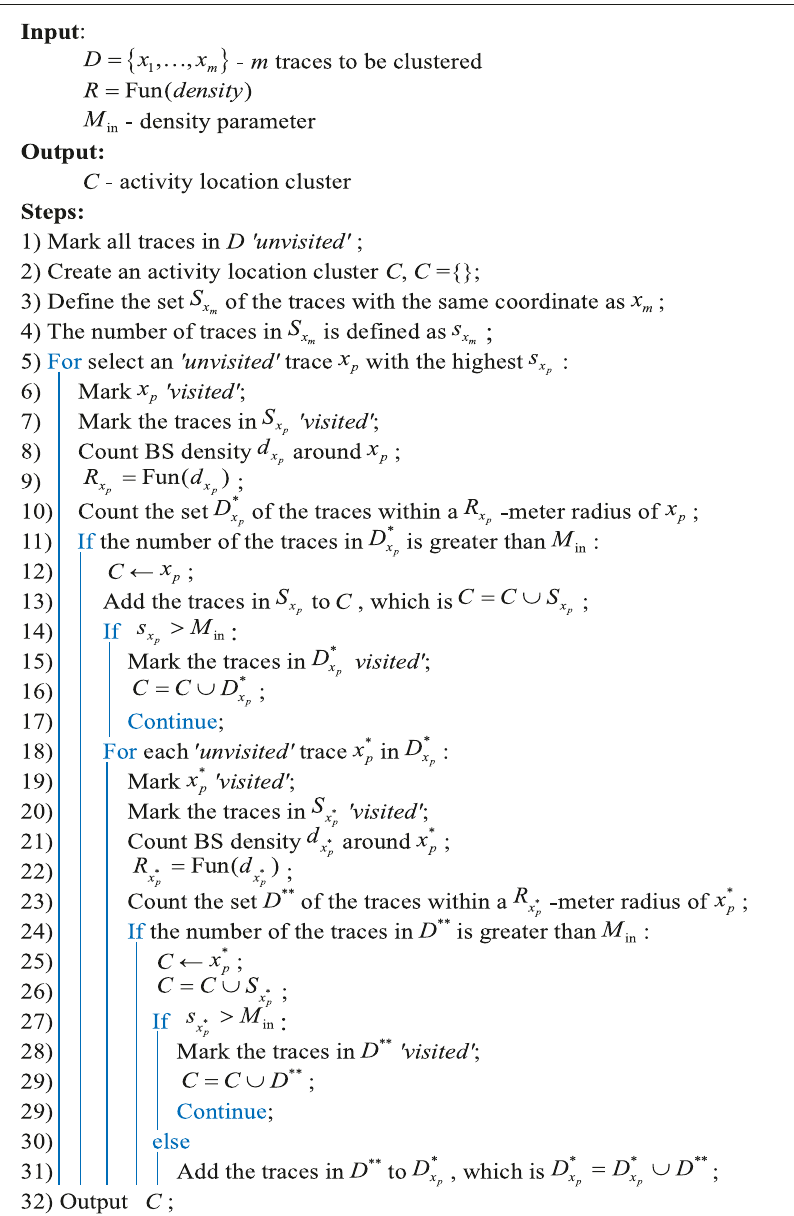
Figure 6: Pseudocode of the improved F-DBSCAN.